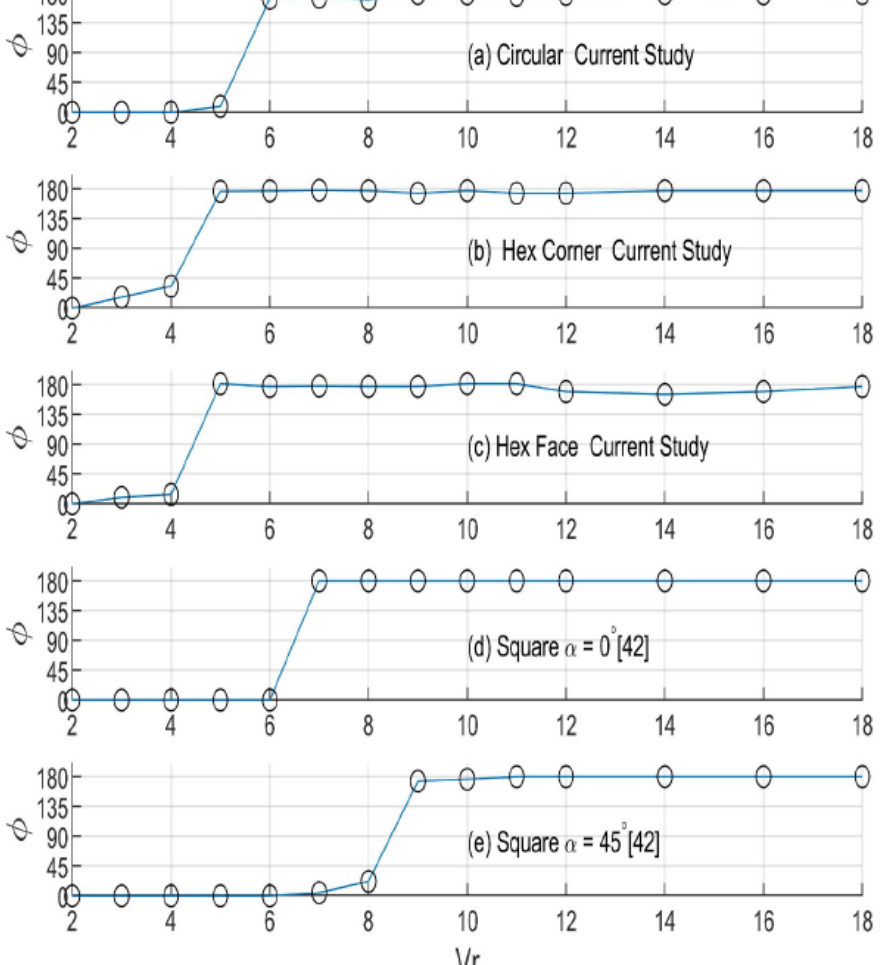
Figure 6. Phase di ff erences between the lift force and cross-flow vibration